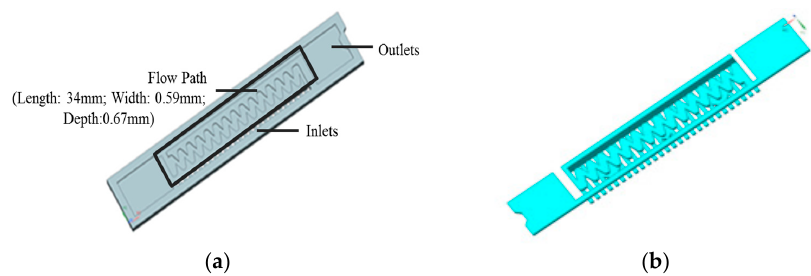
Figure 1. Three-dimensional (3D) structure ( a ) and inner flow field ( b ) of the drip irrigation emitter. Table 1. Experimental treatments.